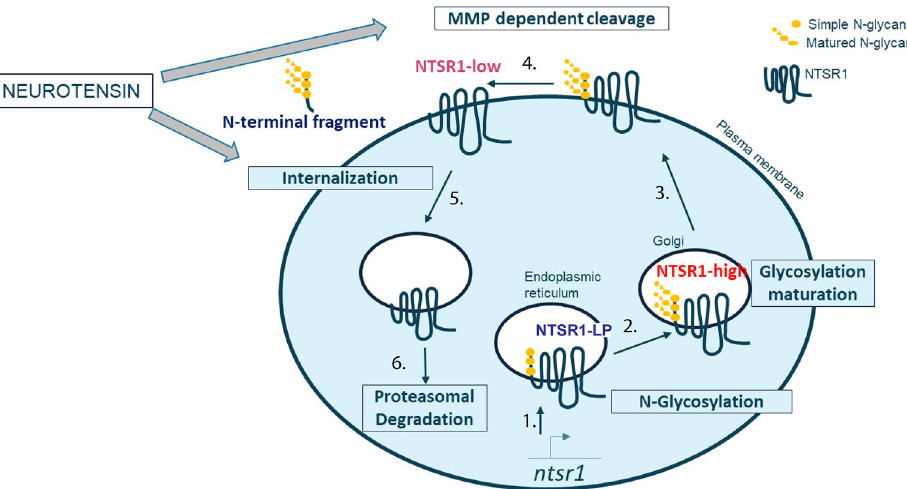
Figure 6. NTSR1 protein biology’s graphical summary. Illustration of NTSR1 biology: 1-NTSR1 is expressed as the NTSR1-LP and co-translationally glycosylated in the ER (Fig. 3); 2-NTSR1 is transported and processed in the Golgi to form the NTSR1-high form Fig. 3; 3-NTSR1 is delivered to the plasma membrane (Figs. 3,5); 4-NTSR-high is cleaved by MMP to form the NTSR1-low protein form (Fig. 4); 5-NTS promotes